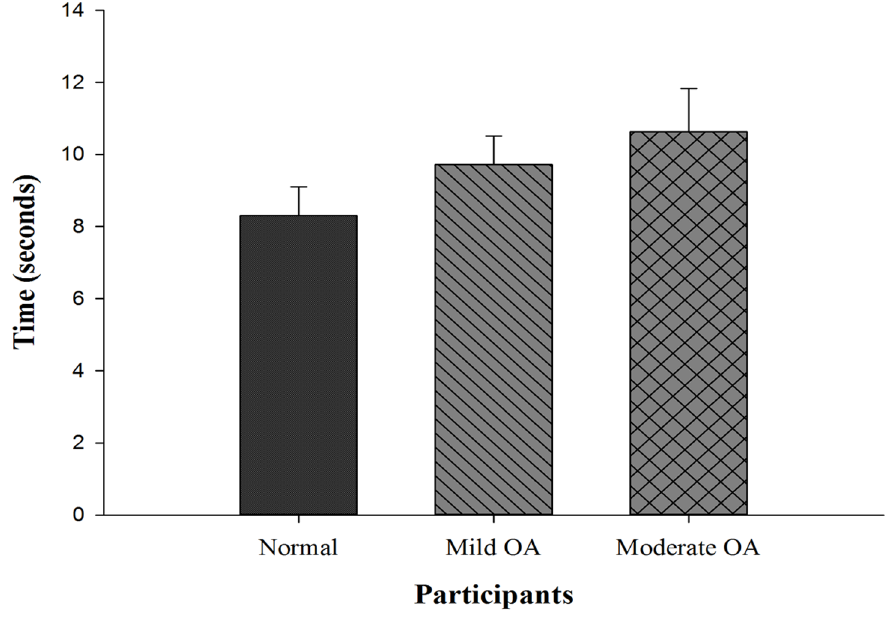
Figure 1. Timed Up and Go test.